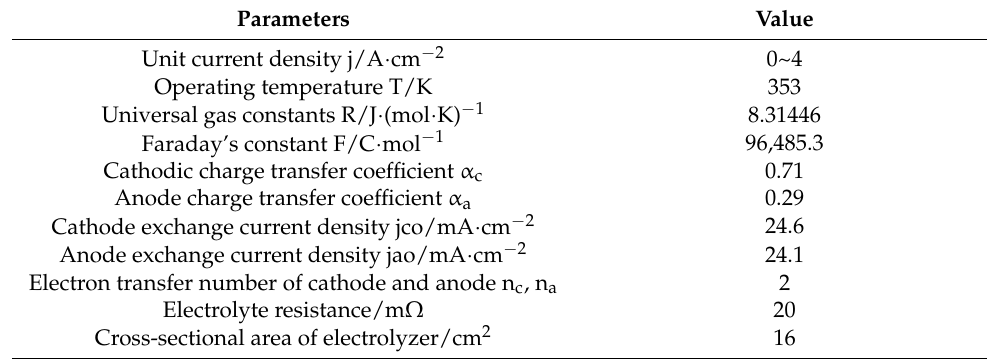
Table 1. Parameters of electrolyzer.